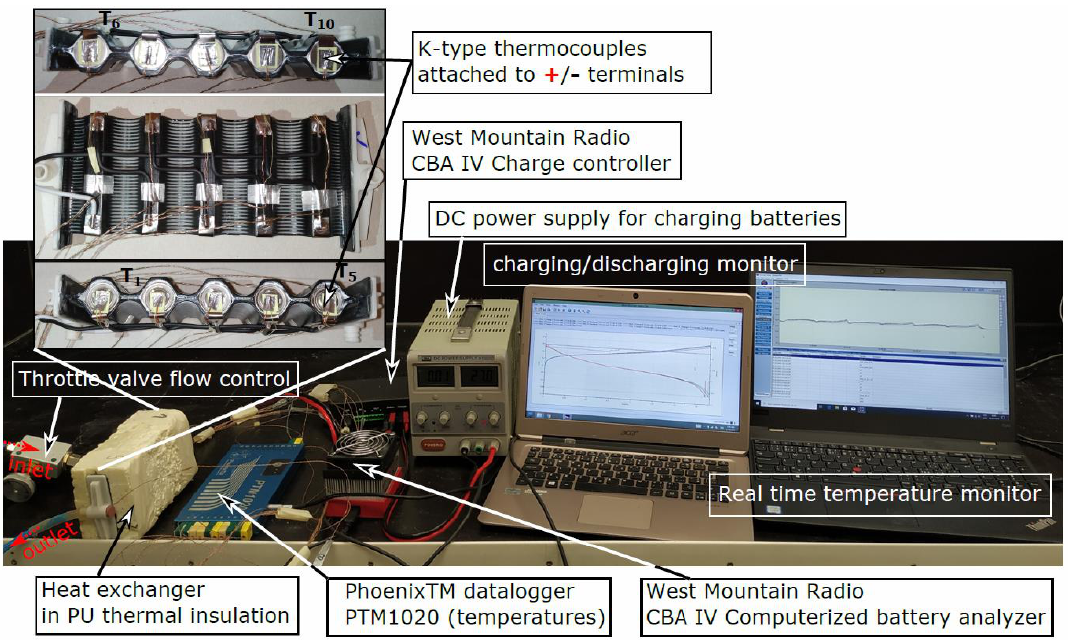
Fig. 3. A photo of the experimental set-up with a detail of wiring Li-ion cells 18650 and the location of K-type